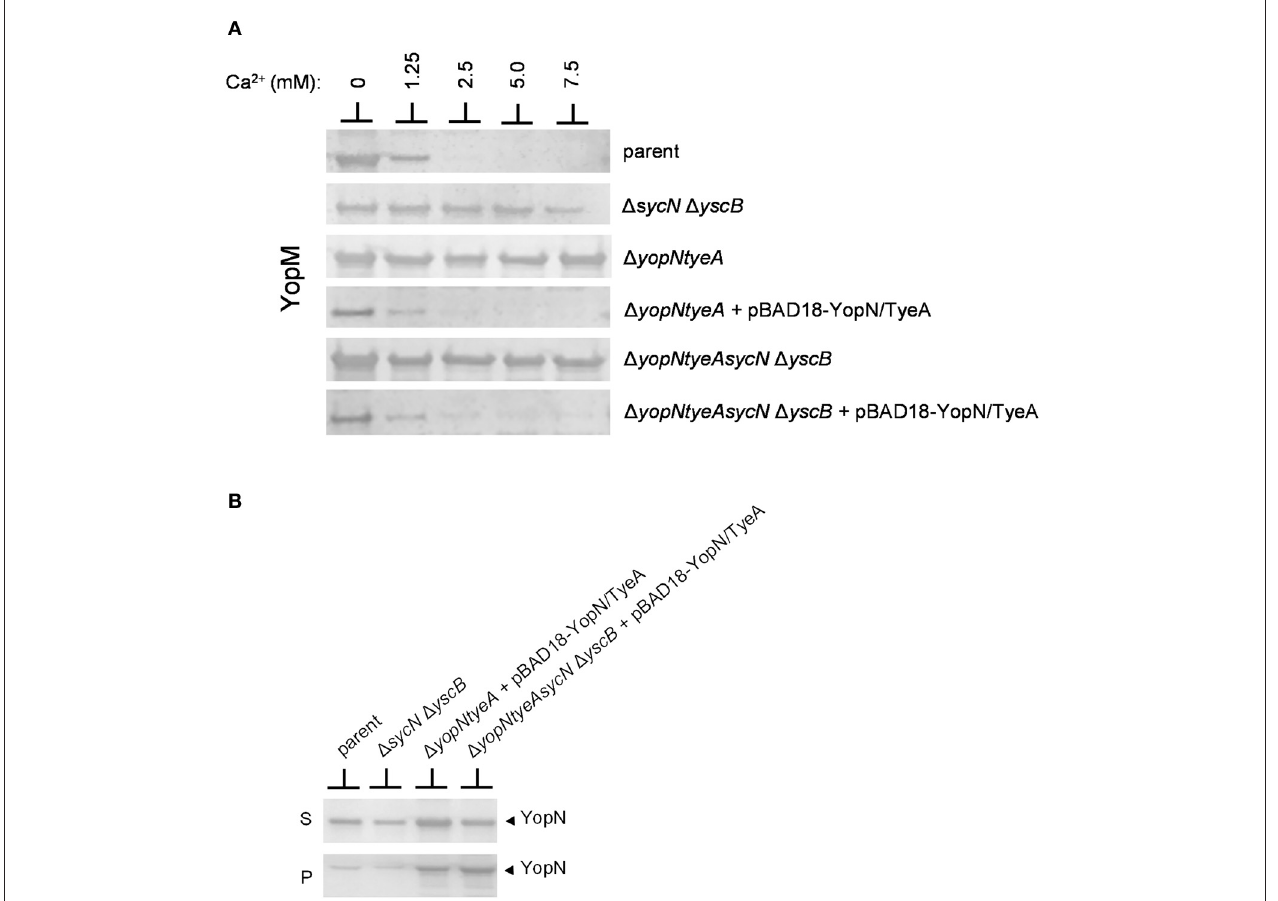
FIGURE 5 | Overexpression of YopN and TyeA results in increased secretion of YopN and negates the requirement of the SycN/YscB chaperone in the calcium-dependent regulation of Yop secretion. (A) Secretion of YopM by Y. pestis KIM8-3001.P39(parent), KIM8-3001.PF1 ( (cid:2) sycN (cid:2) yscB ), KIM8-3001.P71 ( (cid:2) yopN (cid:2) tyeA ), or KIM8.PS2 ( (cid:2) yopN (cid:2) sycN (cid:2) yscB (cid:2) tyeA ) with or without plasmid pBAD18-YopN/TyeA. Y. pestis strains were grown for 5h in the presence of 0mM, 1.25mM, 2.5mM, 5mM, or 7.5mM calcium. Expression of YopN and TyeA from plasmid pBAD18-YopN/TyeAwas induced with 0.2% L-arabinose. Secreted YopM was